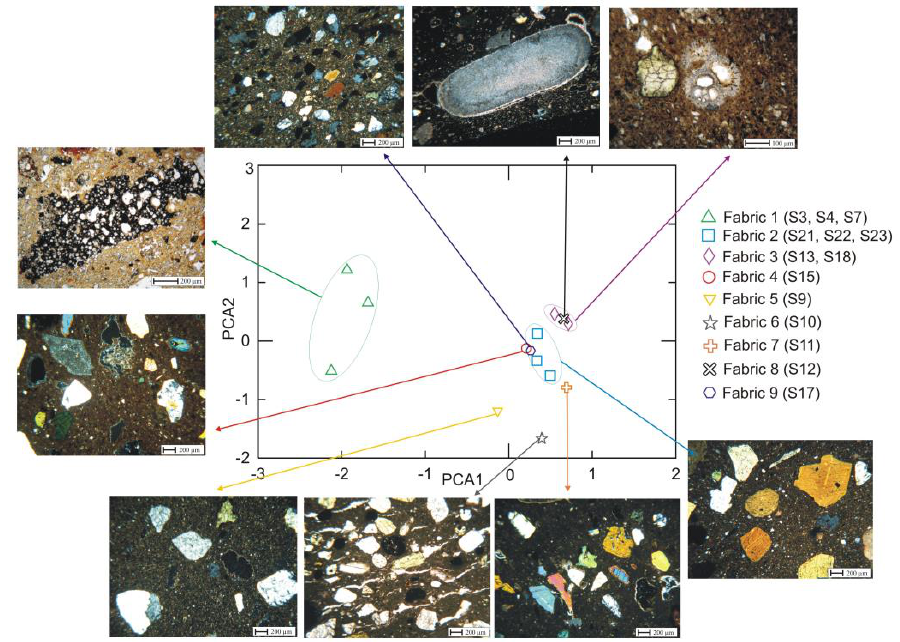
Figure 4. PCA component analysis, obtained by major and trace elements and microphotographs in